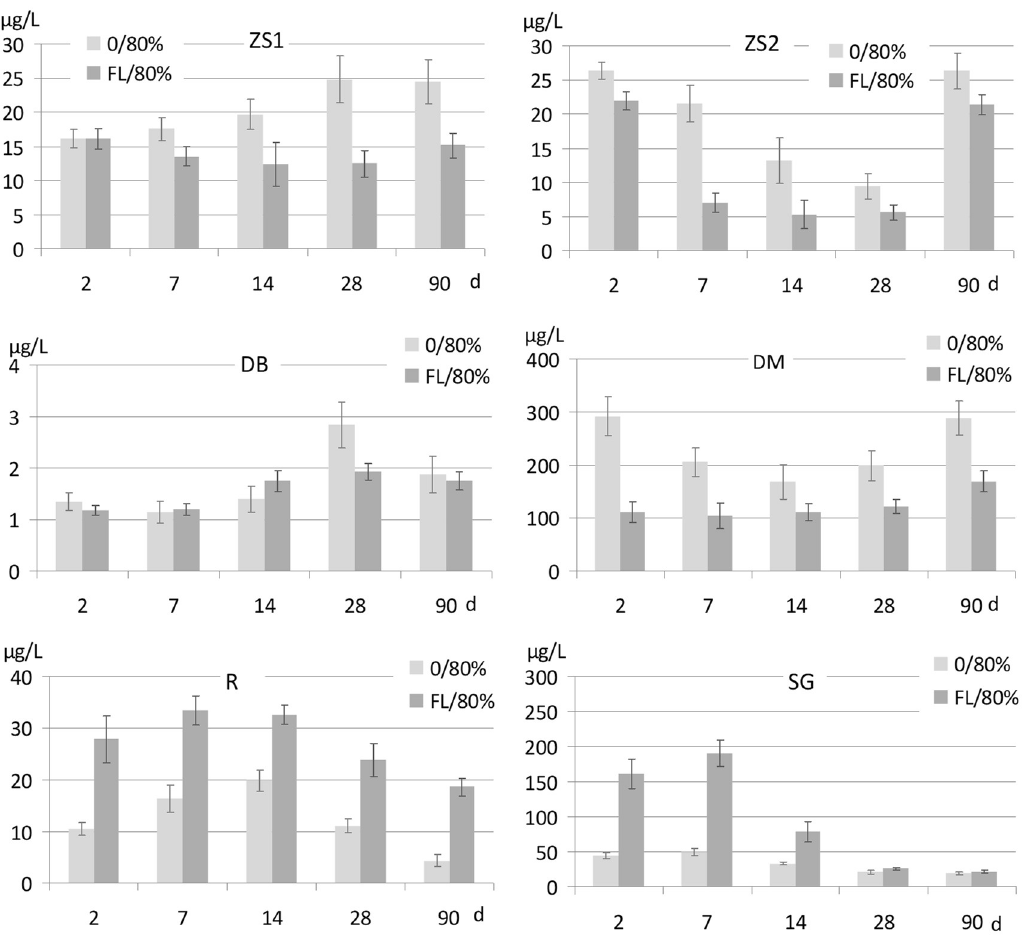
Figure 5. Sb concentrations in pore water of soils incubated at the moisture level of 80% of water holding capacity without addition of forest litter (0/80%) and with beech forest litter (FL/80%).